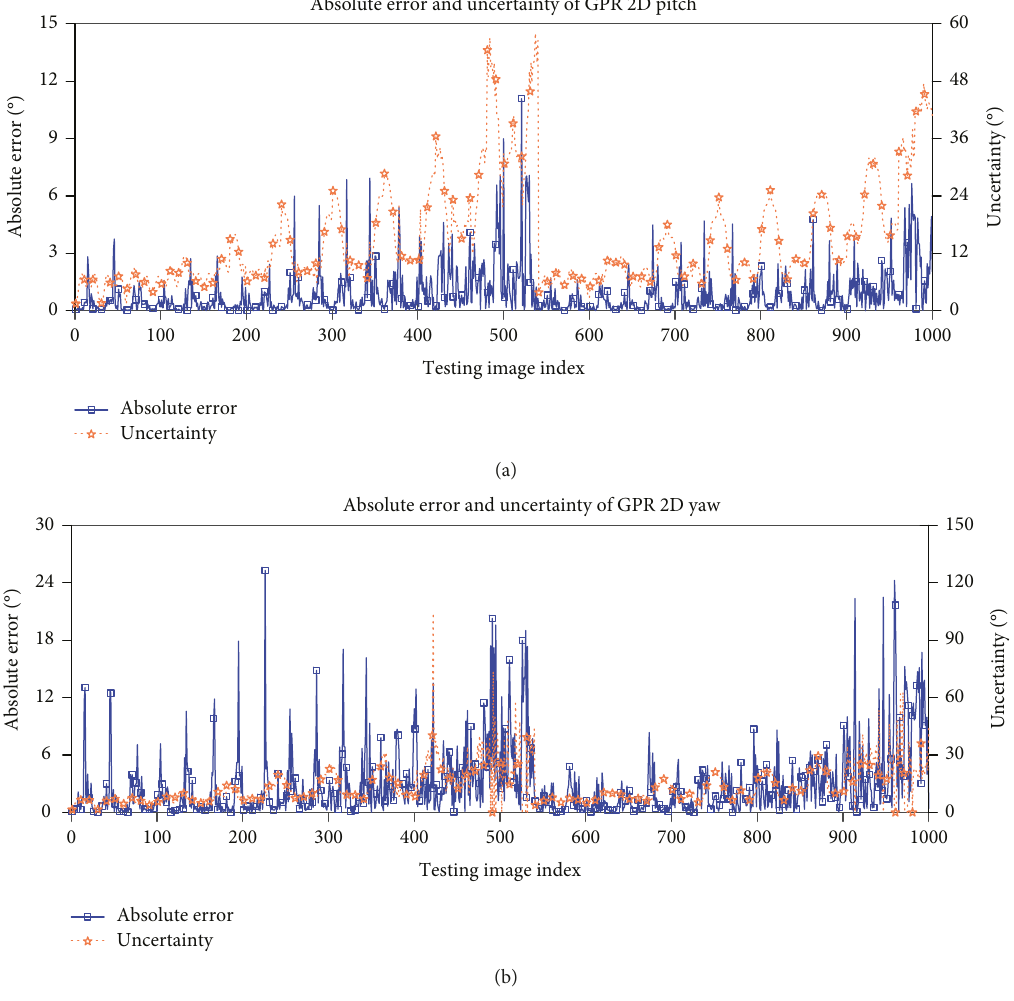
Figure 3: Uncertainty analysis results on the 2D subset of BUAA-SID